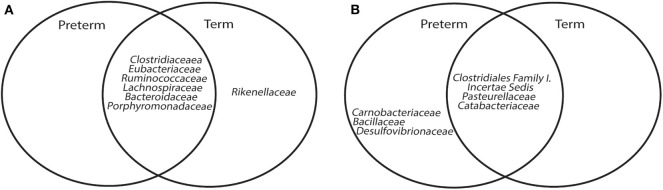
Venn Diagrams of major (A) and minor (B) core microbiome of children born very preterm and at term.